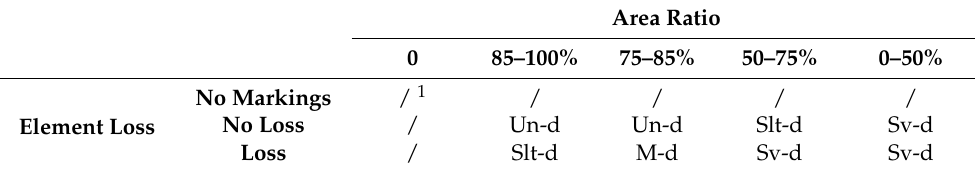
Table 3. The discriminant matrix of assessment on evenly spaced-type marking